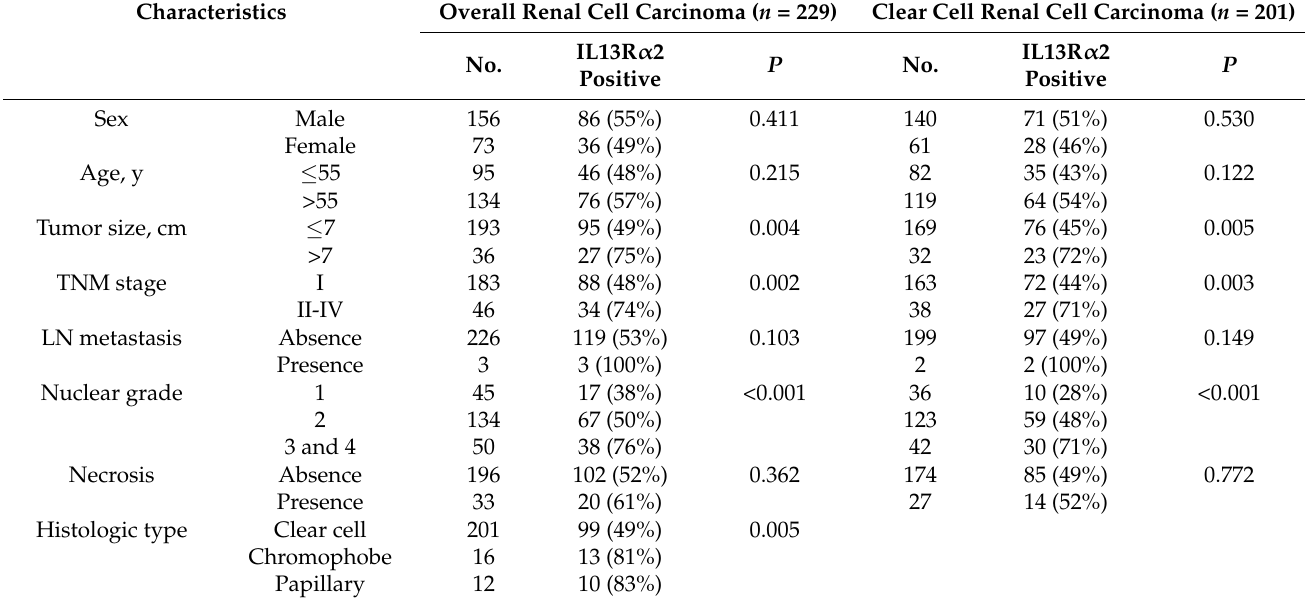
Table 1. Clinicopathologic variables and the expression status of IL13R α 2 in renal cell carcinomas.